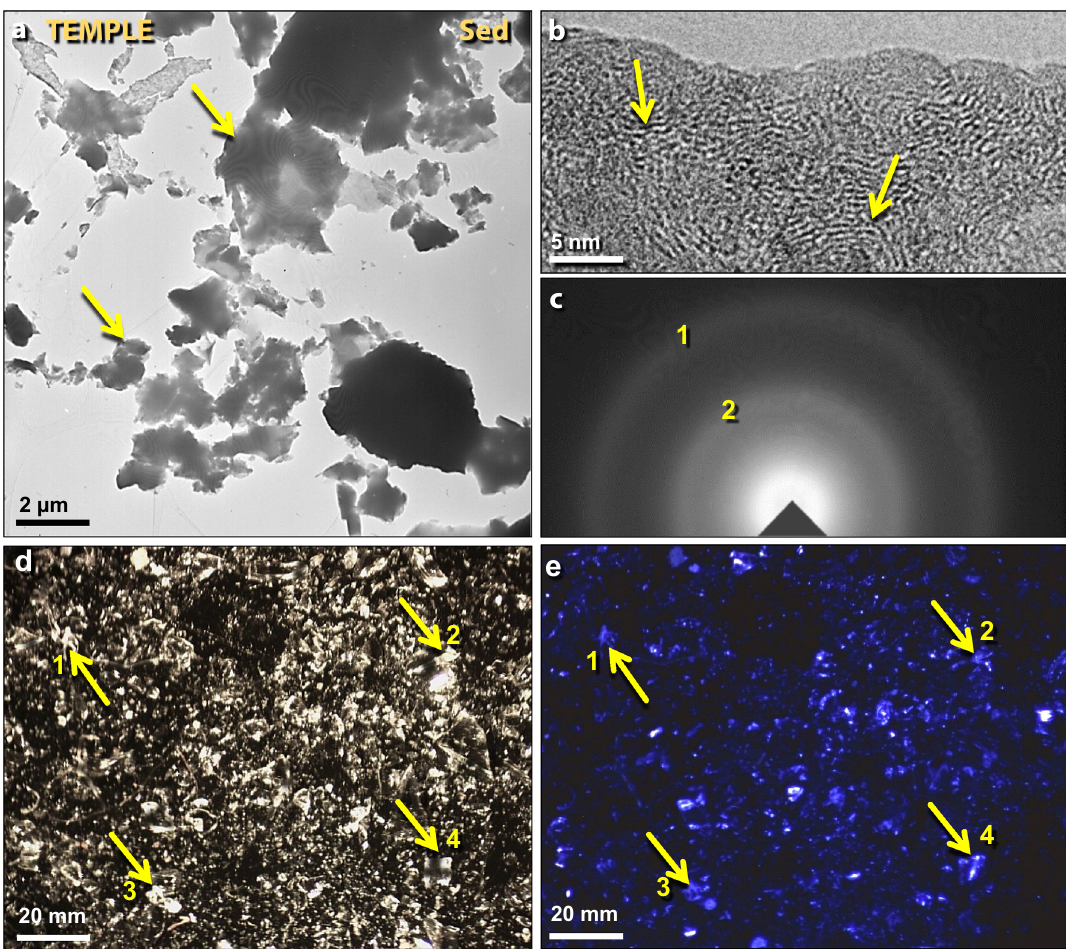
Figure 8. Diamonoids (diamond-like carbon) in temple sediment. ( a ) Transmission electron microscopy (TEM) image of clusters of amorphous diamonoids. ( b ) Bright-field high-resolution transmission electron microscopy (HRTEM) of acid-resistant residue showing the short-range ordering of carbon atoms. ( c ) Selected-area electron diffraction (SAD) of residue and grid film, confirming that the residue is amorphous carbon. ( d ) Photomicrograph of diamonoids showing white to clear material on black carbon SEM tab; ( e ) photomicrograph of the same area as in panel ‘ d ’ showing that the diamonoids luminesce at ~ 440 nm, typical of cubic